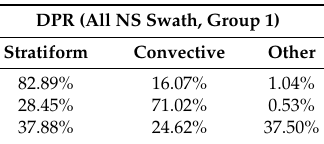
Table 5. The number of matchup pixels in Group 1 (all NS swath) between TRMM PR and GPM DPR, categorized according to precipitation types determined by two datasets. The numbers in parentheses are frequencies relative to the total for each TRMM PR precipitation type (%).